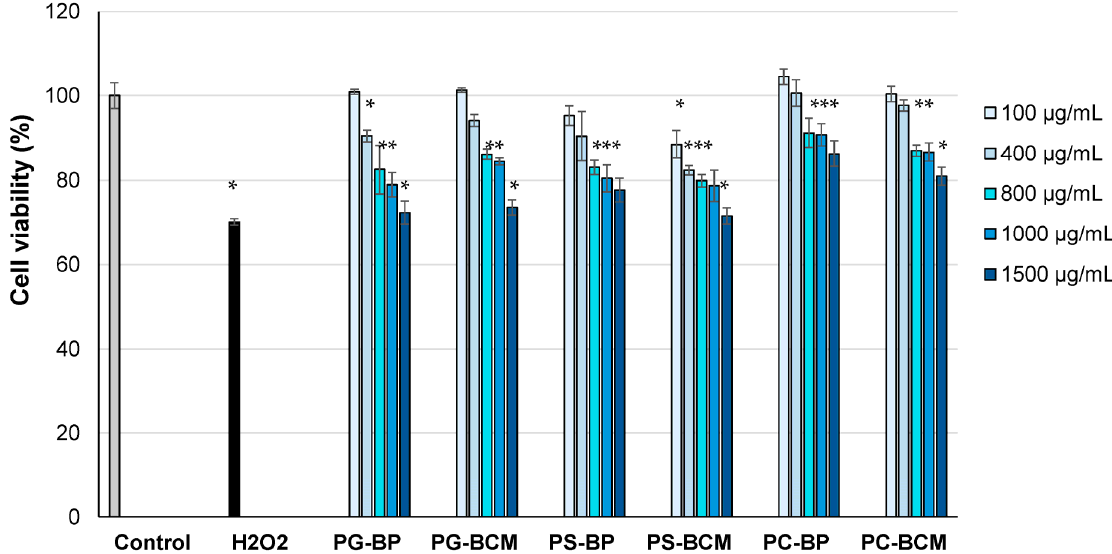
Figure 3. The cell viability of Caco-2 cells treated with post-gastric (PG) and post-intestinal (PS, PC) digestion products of blueberry pomace extract (BP) and BCM mixture for 24 h, assessed by Neutral Red assay. The results are expressed as mean ± SD ( n = 3). * p < 0.05, compared to the untreated cells (control).